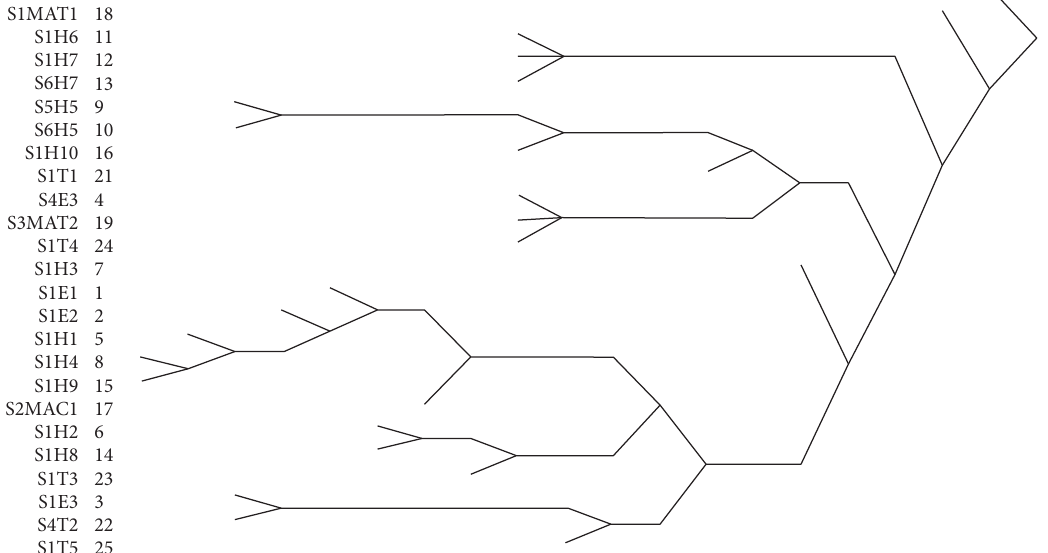
Figure 4: Cohesive subgroup analysis result